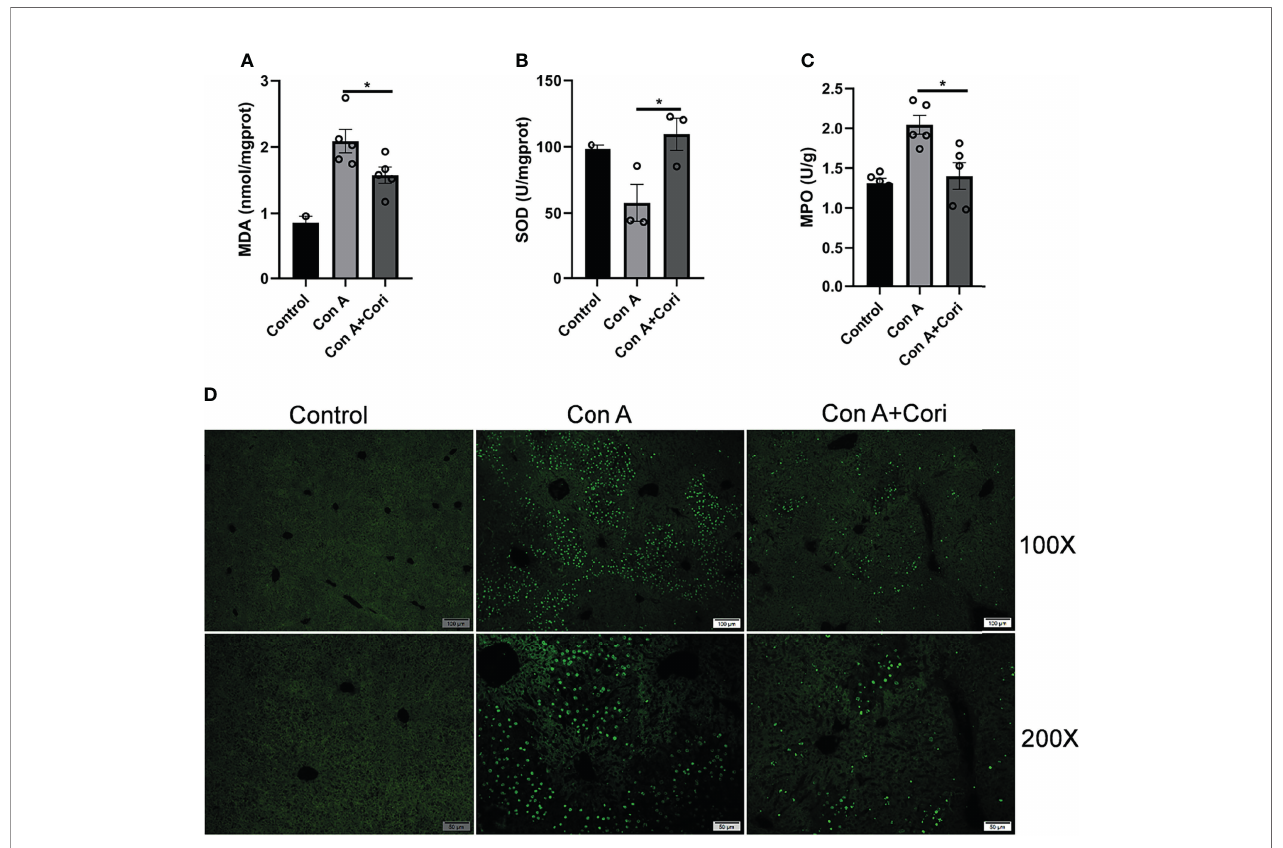
FIGURE 2 | Corilagin attenuates Con A-induced oxidative stress and hepatocyte apoptosis in the liver tissue. Mice were administered corilagin (25 mg/kg) intraperitoneally twice at time intervals of 12 h. After 1 h, mice were challenged with Con A (20 mg/kg body weight). Liver tissues were collected 12 h later. Effects of corilagin on liver (A) malondialdehyde (MDA), (B) Superoxide dismutase (SOD), and (C) myeloperoxidase (MPO). (D) Liver sections stained with TUNEL assay. Original magni fi cation, 100× and 200×. *p <